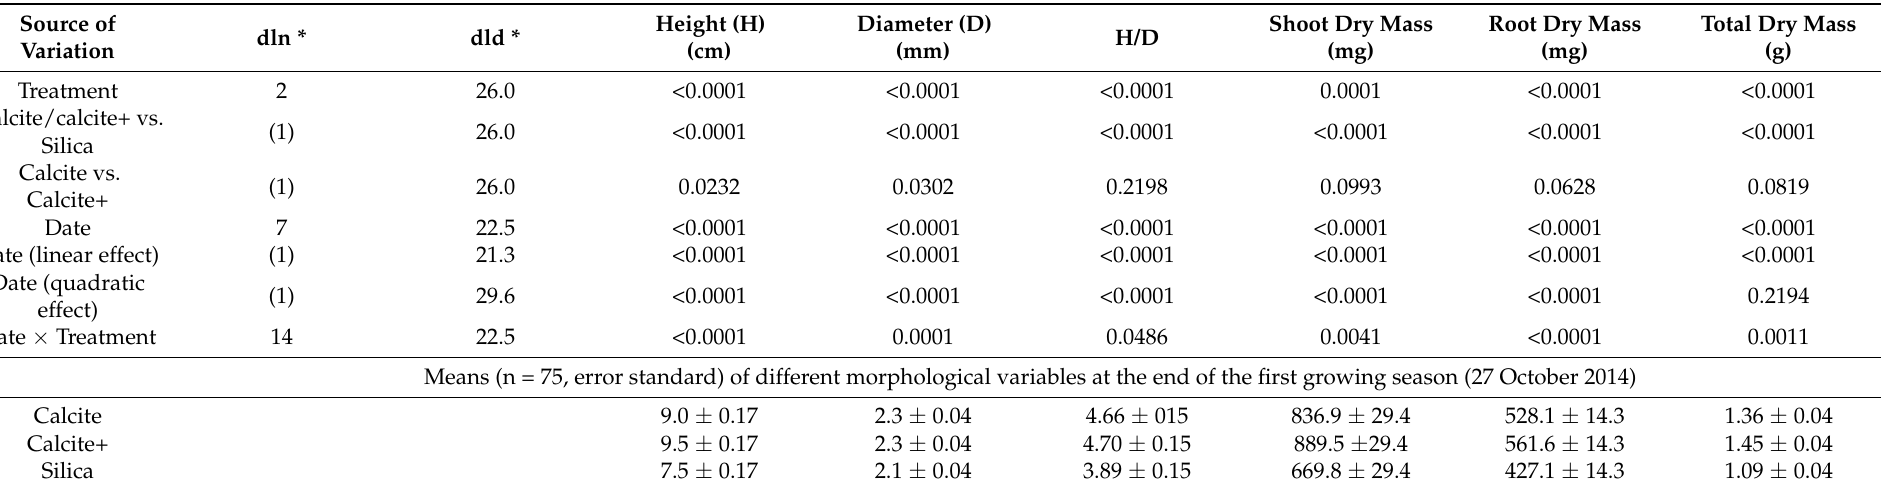
Table 3. Means and observed probabilities ( p values) of fixed effects associated with analysis of variance and means of morphological variables of white spruce seedlings (1 + 0) during the first growing